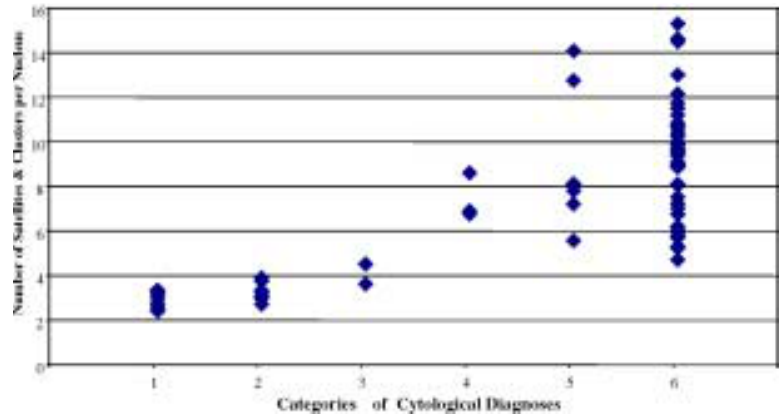
Fig. 3. Mean values of satellites & content of clusters. Categories of cytological diagnoses: 1 = no tumor cells (negative control), 2 = no tumor cells (benign mucosal lesion), 3 = doubtful (histologically no sign of malignancy), 4 = doubtful (histologically proven cancer), 5 = suspicious (histologically proven cancer), 6 = squamous cell carcinoma (histologically proven cancer). This figure can be viewed on http:// www.esacp.org/acp/2003/25-3/remmerbach.htm.